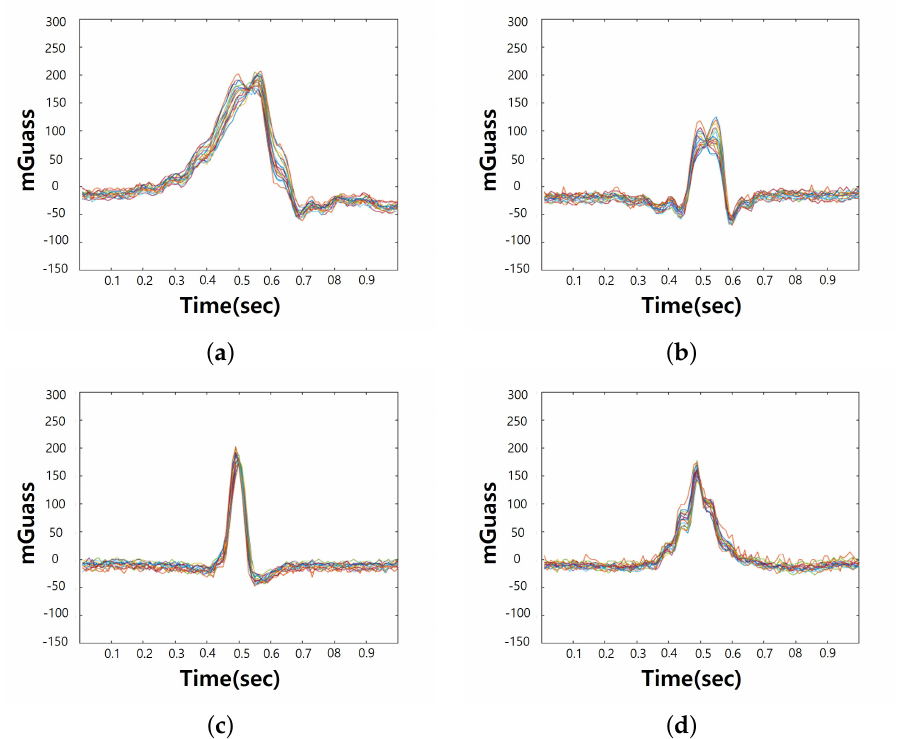
Figure 5. Data samples of z-axis. ( a ) is z-axis of 16ch sample data 1 and ( b ) is z-axis of 16ch sample data 2, ( c ) is z-axis of 16ch sample data 3, ( d ) is z-axis of 16ch sample data